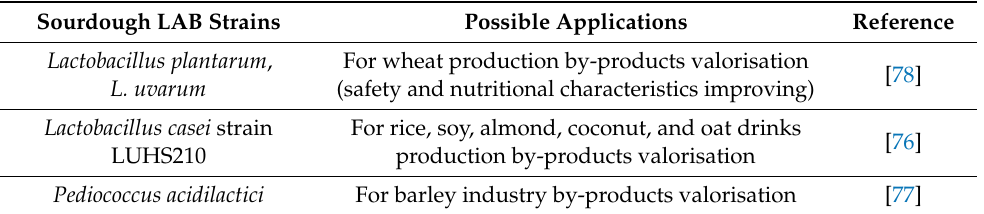
Table 2. Possible applications of sourdough LAB for the valorisation of by-products. Sourdough LAB Strains Possible Applications